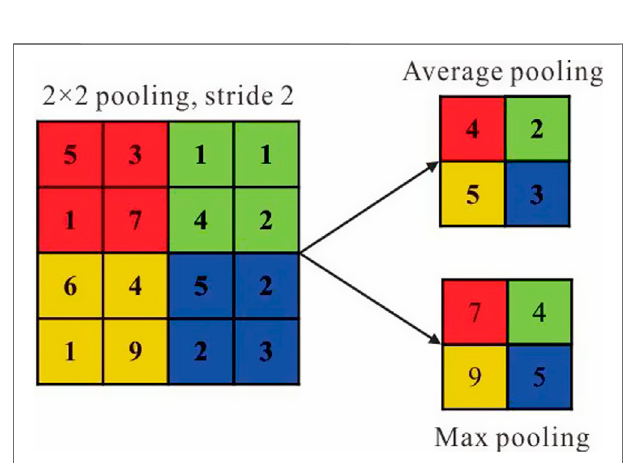
FIGURE 5 | Two pooling methods in Convolutional neural network.